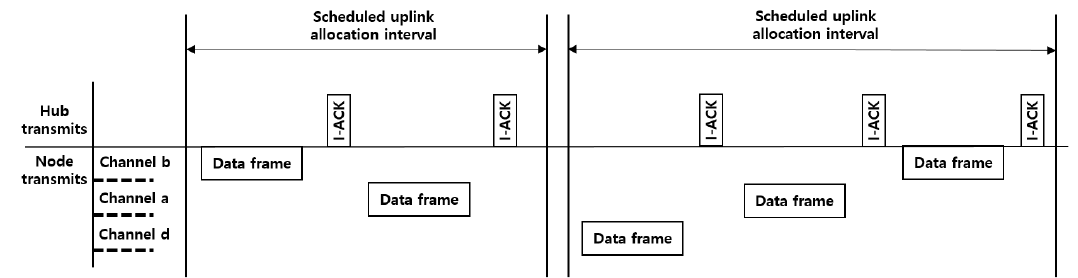
Figure 14. Frame transactions using channel hopping in